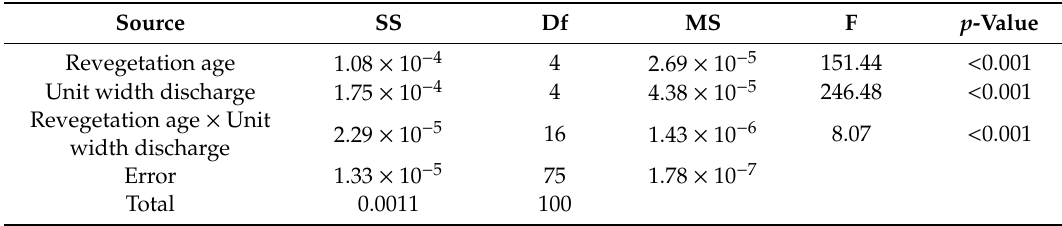
Table 2. Summary of two-way ANOVAs